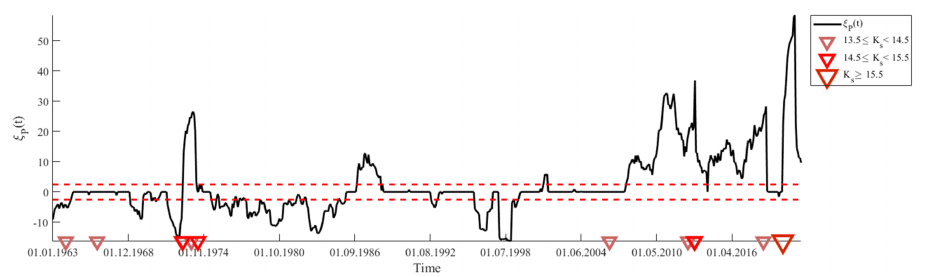
Figure 3. Temporary values of the parameter ξ P for region S 2 . Red triangles on the time axis indicate earthquakes with K S ≥ 13 . 5 ( M ≥ 6 . 0).